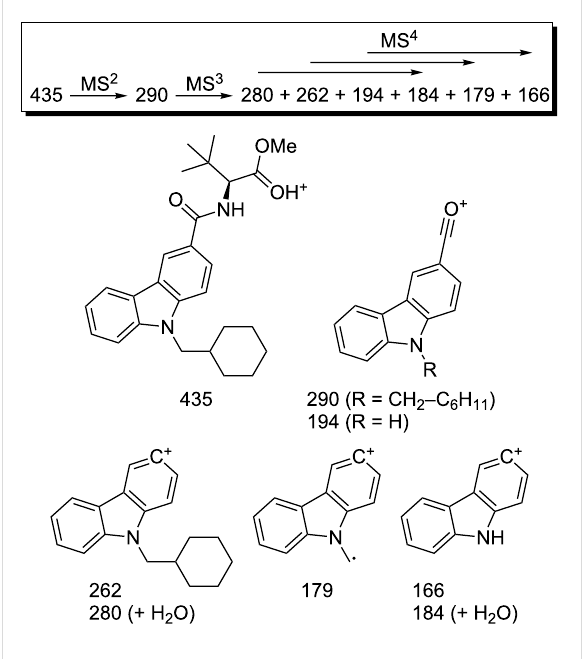
Figure 3: ESI-MS n pattern of 3 ( m / z values) with probable fragment ion structures.